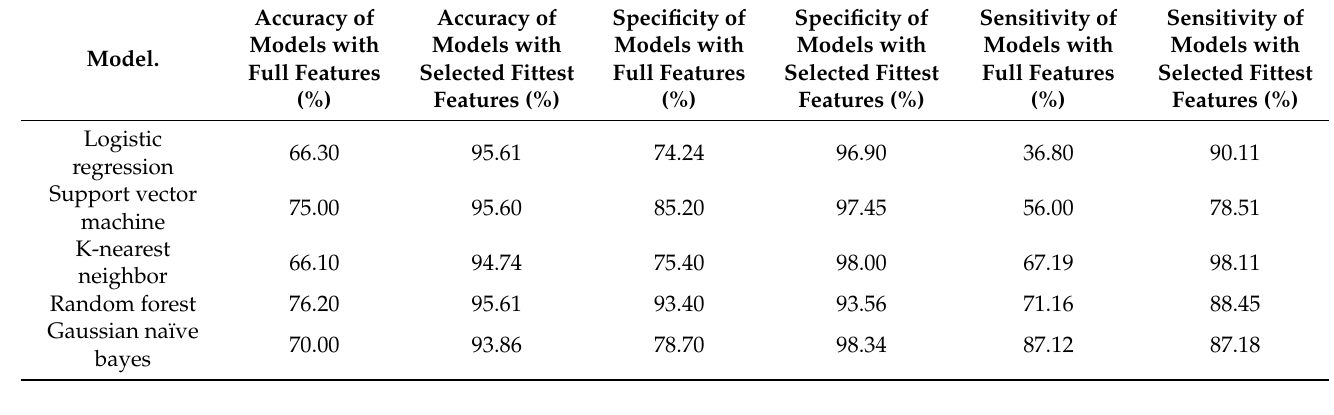
Table 4. Performance evaluation of classification models with full features against that of the models with selected fittest features.